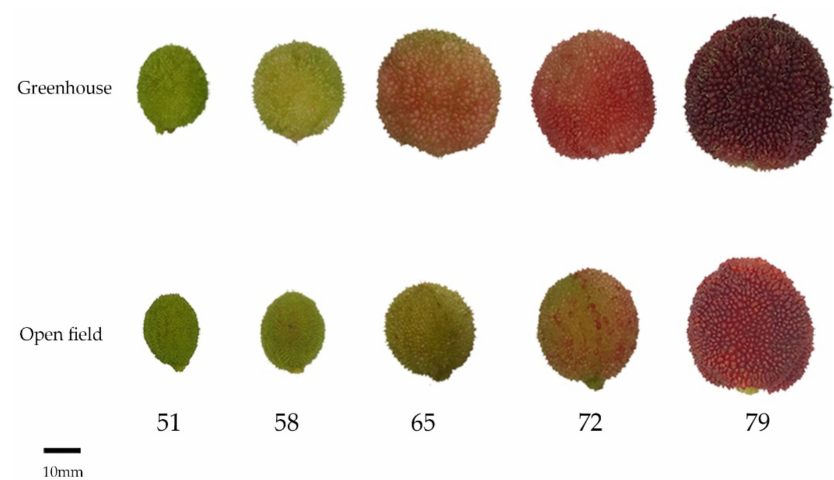
Figure 2. Development stages of ‘Dongkui’ under different cultivation. Numbers of mean fruits at 51, 58, 65, 72, 79 days after flowering.